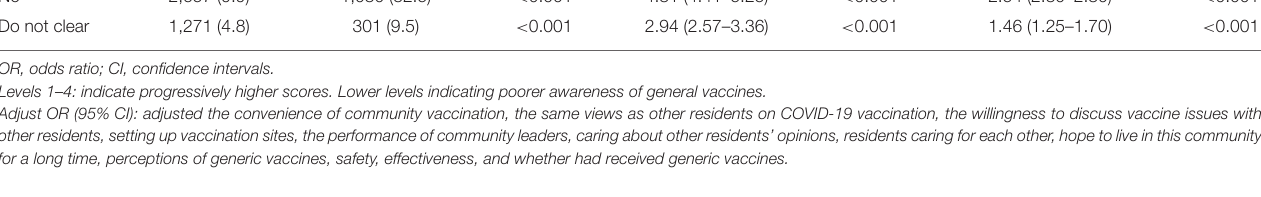
TABLE 4 | Associations of coronavirus skepticism, COVID-19 vaccine skepticism, trust in healthcare system with COVID-19 vaccination coverage rate.